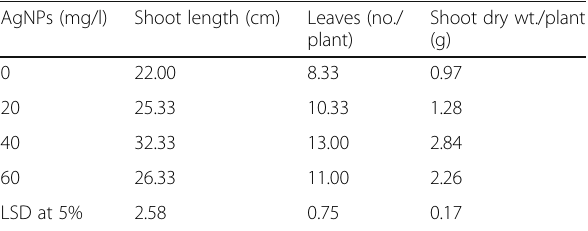
Table 1 Effect of different concentrations of AgNPs on growth criteria of fenugreek plants at 60 DAS (data are means of two seasons) AgNPs (mg/l) Shoot length (cm) Leaves (no./